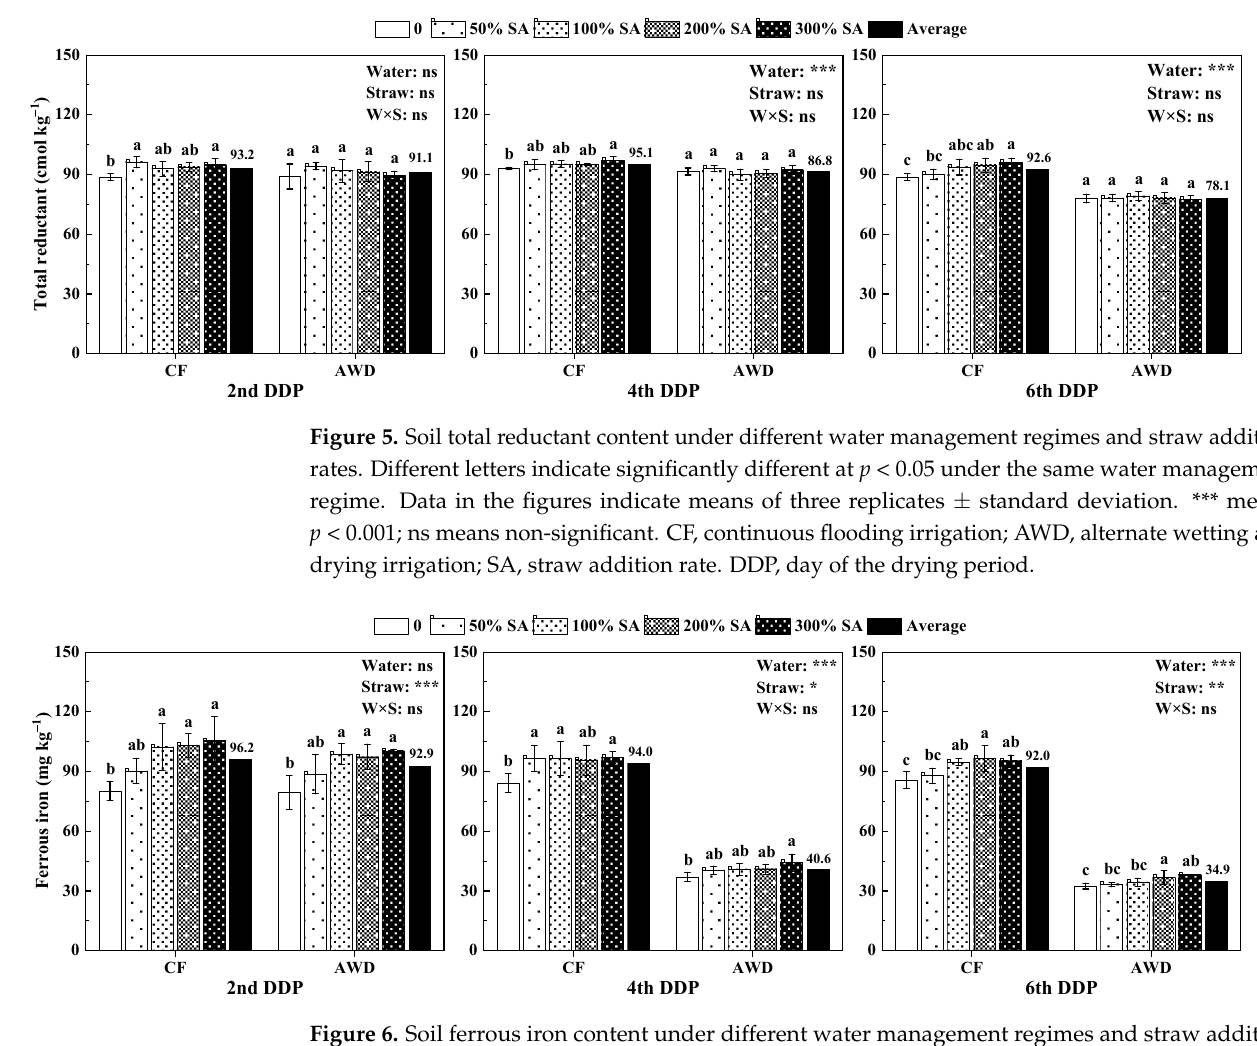
Figure 6. Soil ferrous iron content under different water management regimes and straw addition rates. Different letters indicate significantly different at p < 0.05 under the same water management regime. Data in the figures indicate means of three replicates ± standard deviation. * means p < 0.05; ** means p < 0.01; *** means p < 0.001; ns means non ‐ significant. CF, continuous flooding irrigation; AWD, alternate wetting and drying irrigation; SA, straw addition rate. DDP, day of the drying pe ‐ riod.